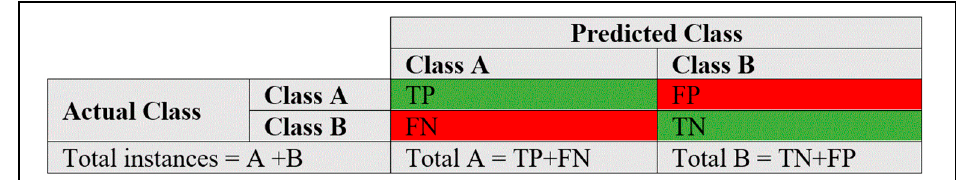
Figure 7. Confusion matrix.